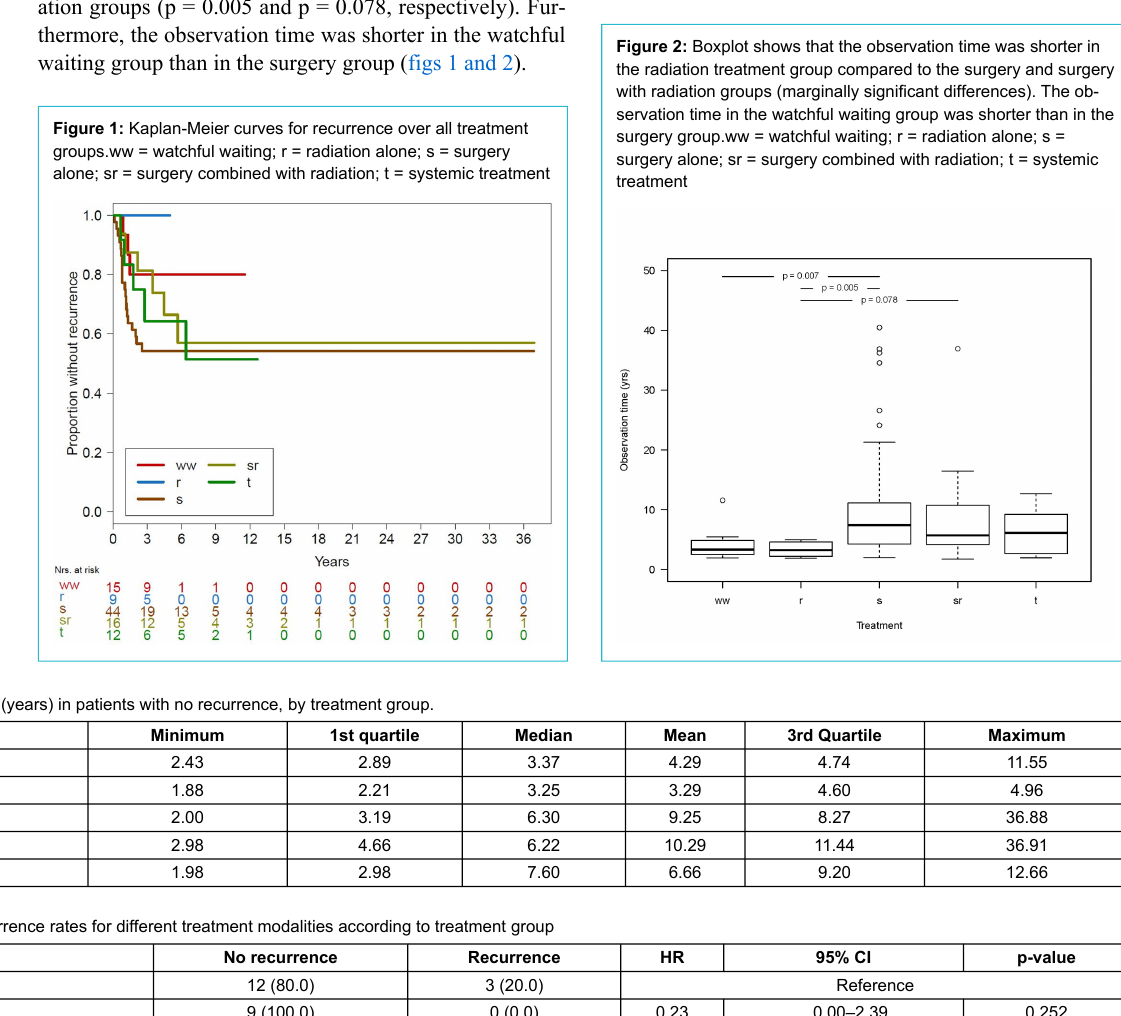
Figure 1: Kaplan-Meier curves for recurrence over all treatment groups.ww = watchful waiting; r = radiation alone; s = surgery